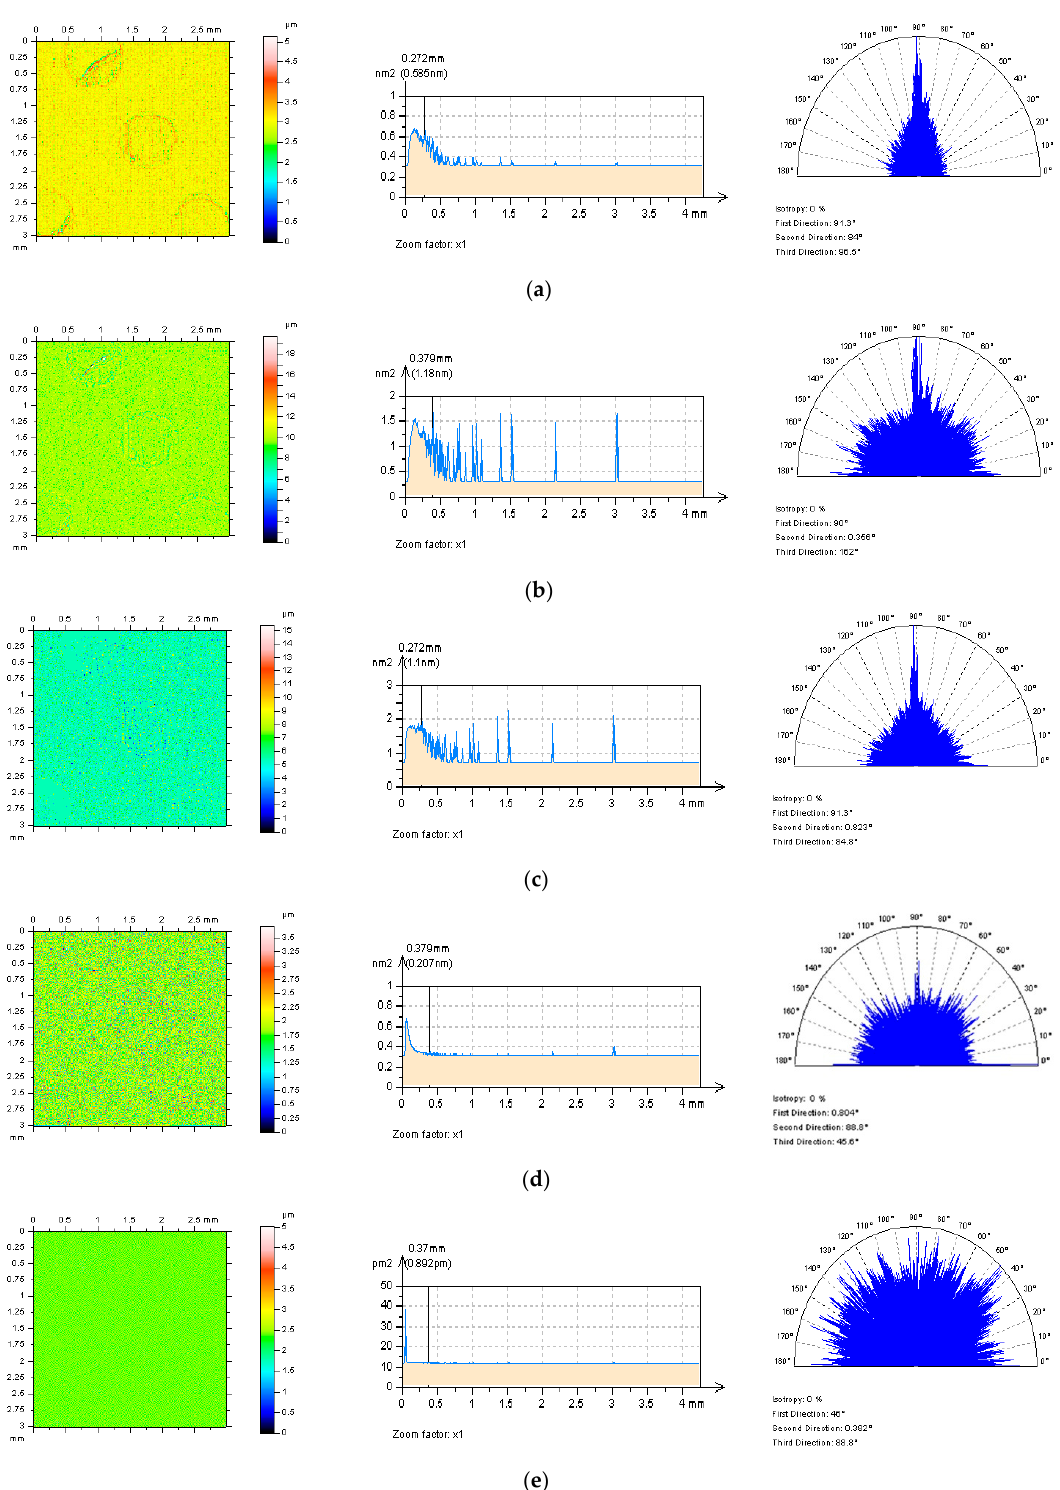
Figure 11. NSs (left column), PSDs (middle column) and texture direction graphs (right column), specified for results of 0.7 mm/s measurements of the running-in plateau-honed cylinder liner surface texture, obtained by the application of various S-filtering methods (cut-off = 0.025 mm), as follows: GF ( a ), RGF ( b ), DMF ( c ), SF ( d ) and FFTF ( e ).